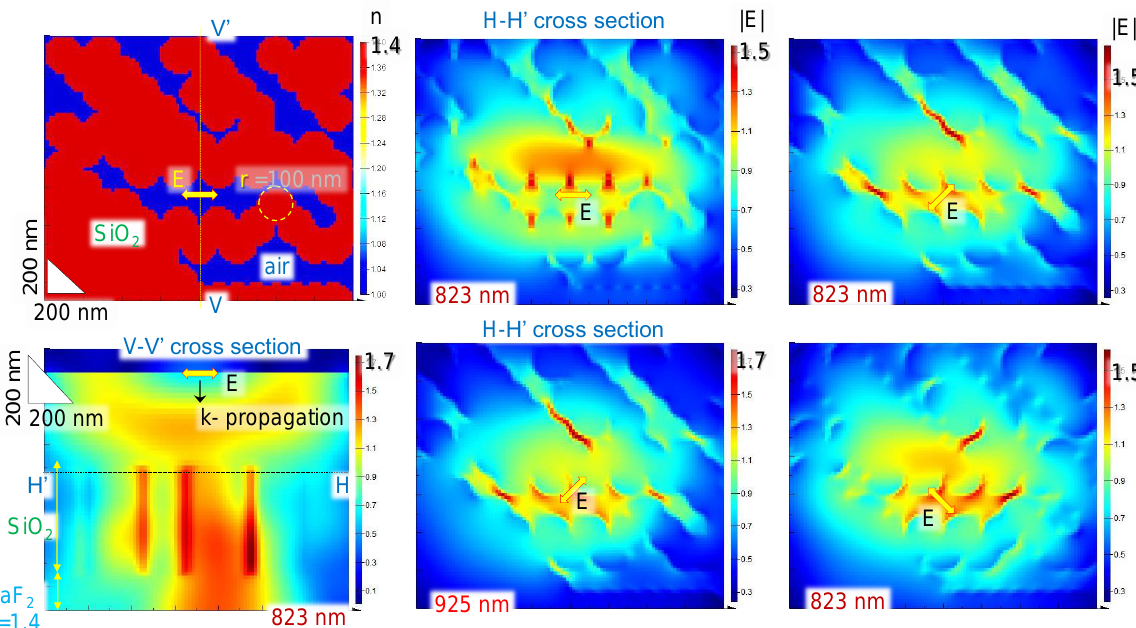
Figure A2. A numerical toy-model of light scattering and enhancement by a SiO 2 ( n = 1.4) columnar pattern on CaF 2 for different orientations of the incident linearly polarised E -field (0; ± π /4) of light calculated by finite difference time domain (FDTD) solver (Lumerical). Transverse V’-V and longitudinal H’-H cross sections show ( E / E 0 ) -field enhancement for the incident plane wave E 0 = 1. The radius of SiO 2 cylinders r = 100 nm; perfectly matching boundary conditions were used. The inset shows 3D rendering of the calculation